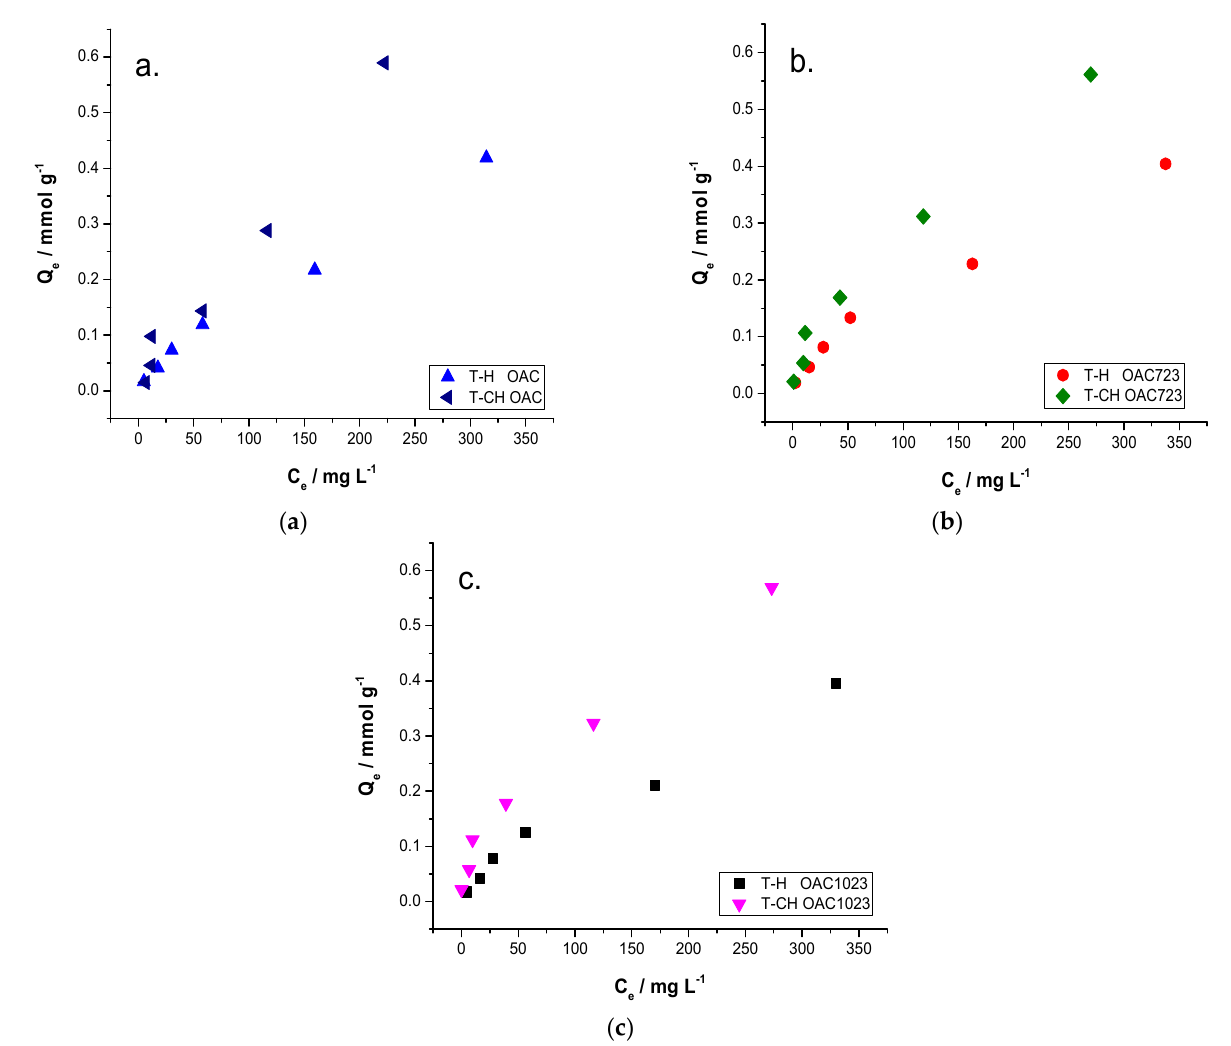
Figure 3. Experimental data of liquid-phase isotherms for the adsorption of solutions of toluene in hexane and cyclohexane for OAC ( a ), OAC723 ( b ) y OAC1023 ( c ).